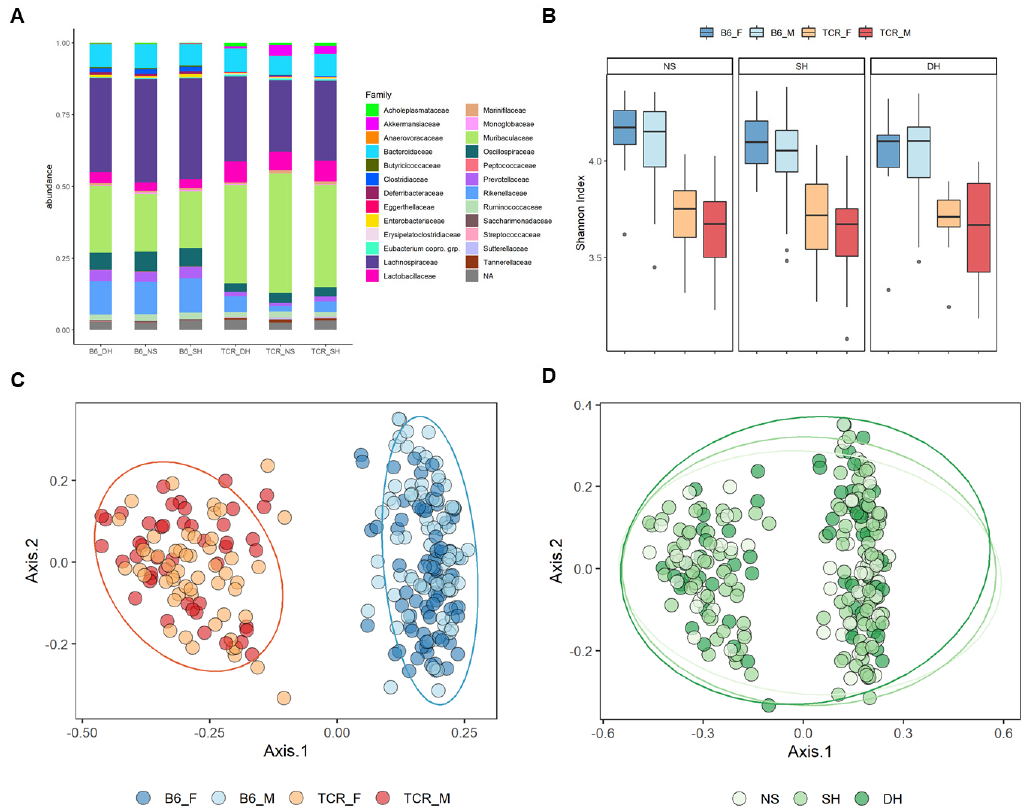
Figure 4. Gut microbiome characteristics vary between T-cell-deficient and WT mice. ( A ) Average relative abundances of recognized bacterial families based on 16S sequence data between experi- mental groups (genotype, sex, and stress condition). ( B ) Alpha diversity plots showing decreased Shannon index in T-cell-deficient mice compared to controls ( C , D ) and beta diversity plots to visualize compositional in the microbiota between the T-cell-deficient (orange) and WT (blue) mice. PCoA plot of Bray–Curtis index ( C ) coloured by genotype and sex and ( D ) coloured by stress con- dition, highlighting the dominant effect of genotype on microbiome structure.